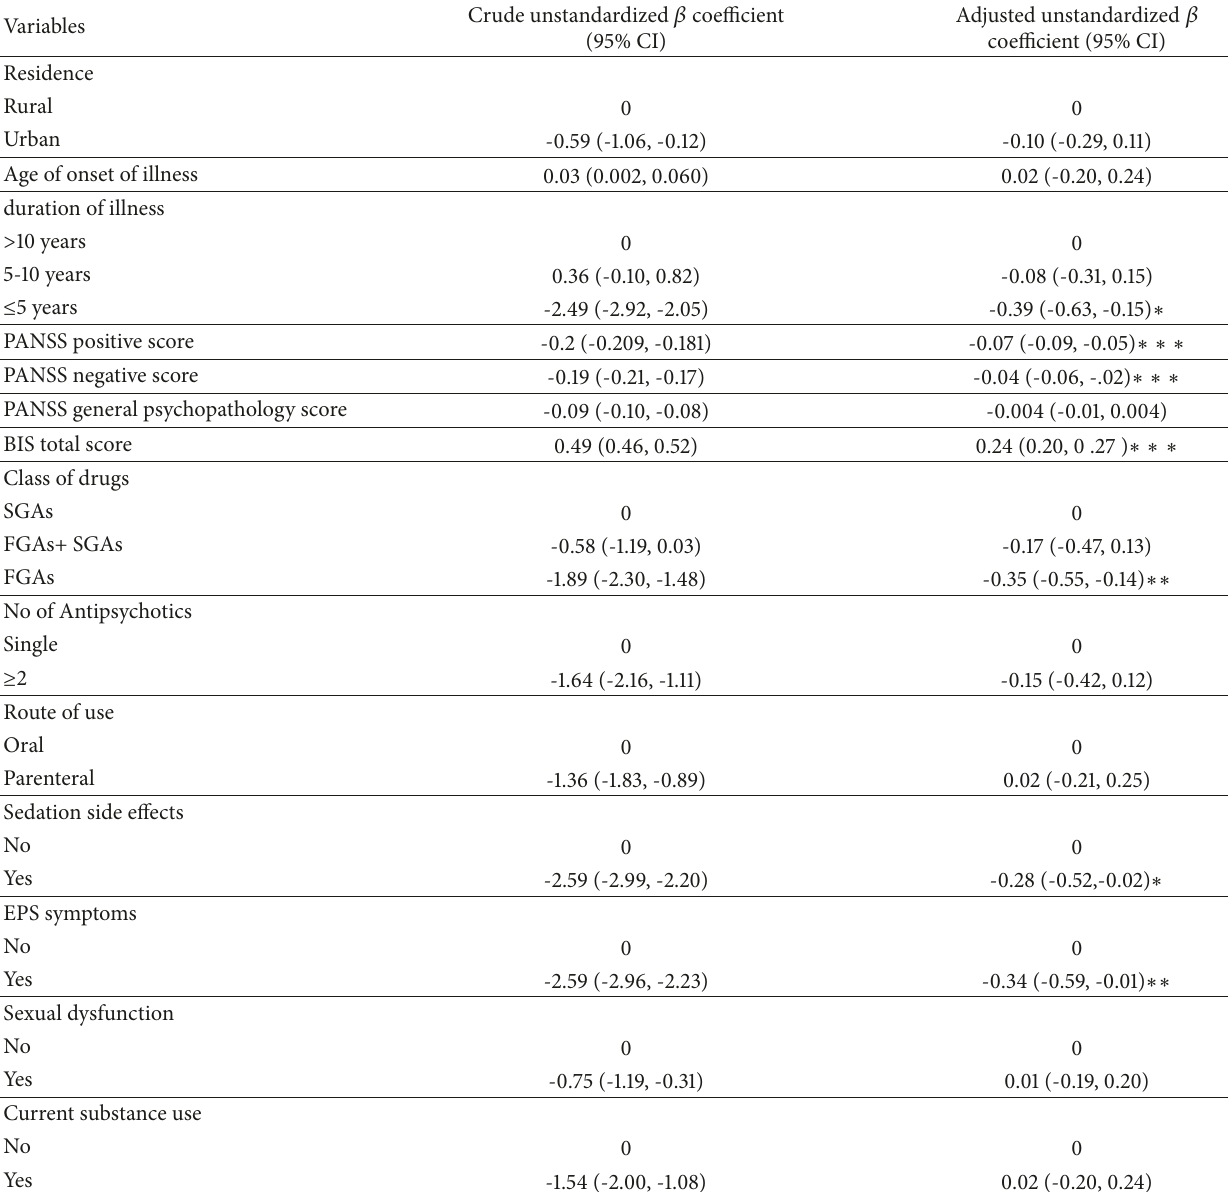
Table 4: Factors associated with attitude towards antipsychotic medications during multiple linear regression analysis (n=393).